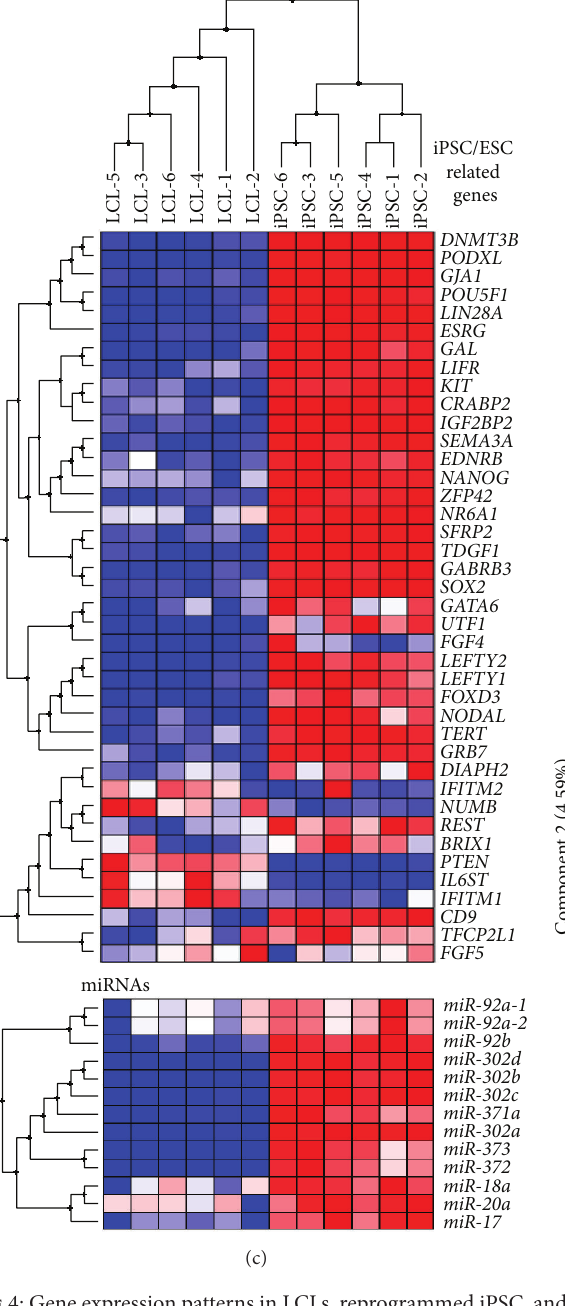
Figure 4: Gene expression patterns in LCLs, reprogrammed iPSC, and ESCs. (a) Expression pattern of all DE mRNAs and miRNAs in LCLs and their reprogrammed iPSCs. (b) Expression profiles of LCL specific mRNAs and miRNAs in LCLs and their reprogrammed iPSCs. (c) Expression profiles of mRNAs and miRNAs known from the literature to be involved in maintenance of pluripotency and stemness in human ESC/iPSCs. (d) PCA on gene expression profiles of six LCLs and their reprogrammed iPSCs generated in this study and three ESC and four iPSC gene expression profiles downloaded from the GEO